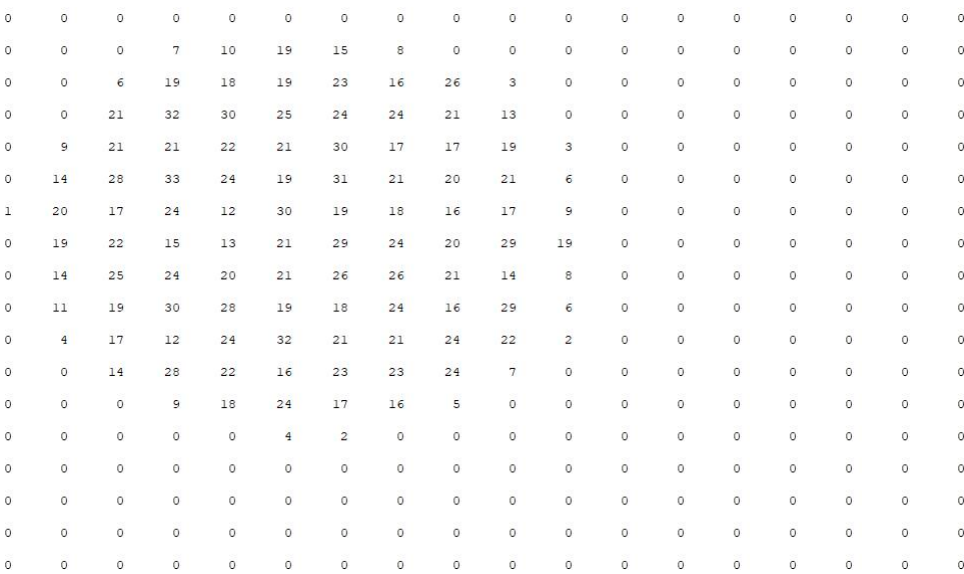
Figure 2. Data distribution of partition function p = 18.